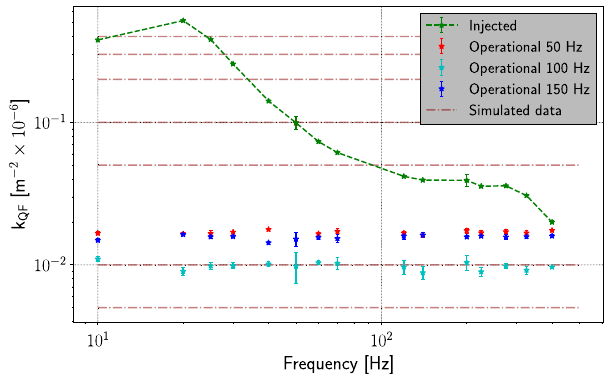
FIG. 12. Comparison between the transfer function points from the experimental data (blue continuous line), the full MADX simulation model (dashed green line), and the 2D empirical transfer map (dot-dashed orange